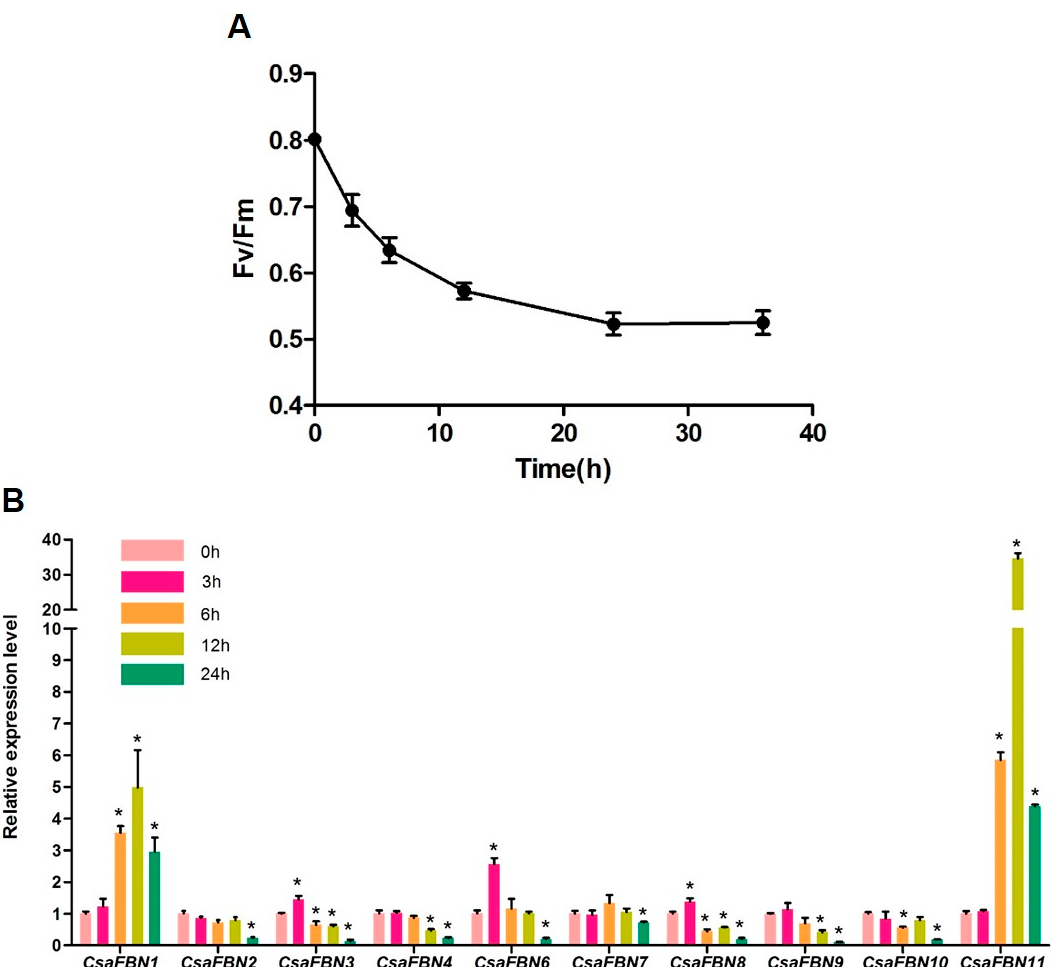
Figure 4. Photosynthetic capacity and FBN s expression under the high light with chilling stress. ( A ) Fv/Fm values of cucumber during the stressed condition ( B ) Transcript level of CsaFBN genes under the high-light with chilling stress. Transcript expression was analyzed by quantitative real-time RT-PCR. The EUKARYOTIC TRANSLATION INITIATION FACTOR 4A1 (eIF4a, Csa7G450710) gene from cucumber was used as an internal control. Biological triplicates were averaged. Bars indicate the standard error of the mean. Statistically significant expression differences of gene between 0 h and high light treatment are indicated by asterisks (* p < 0.05, Student’s t-test).